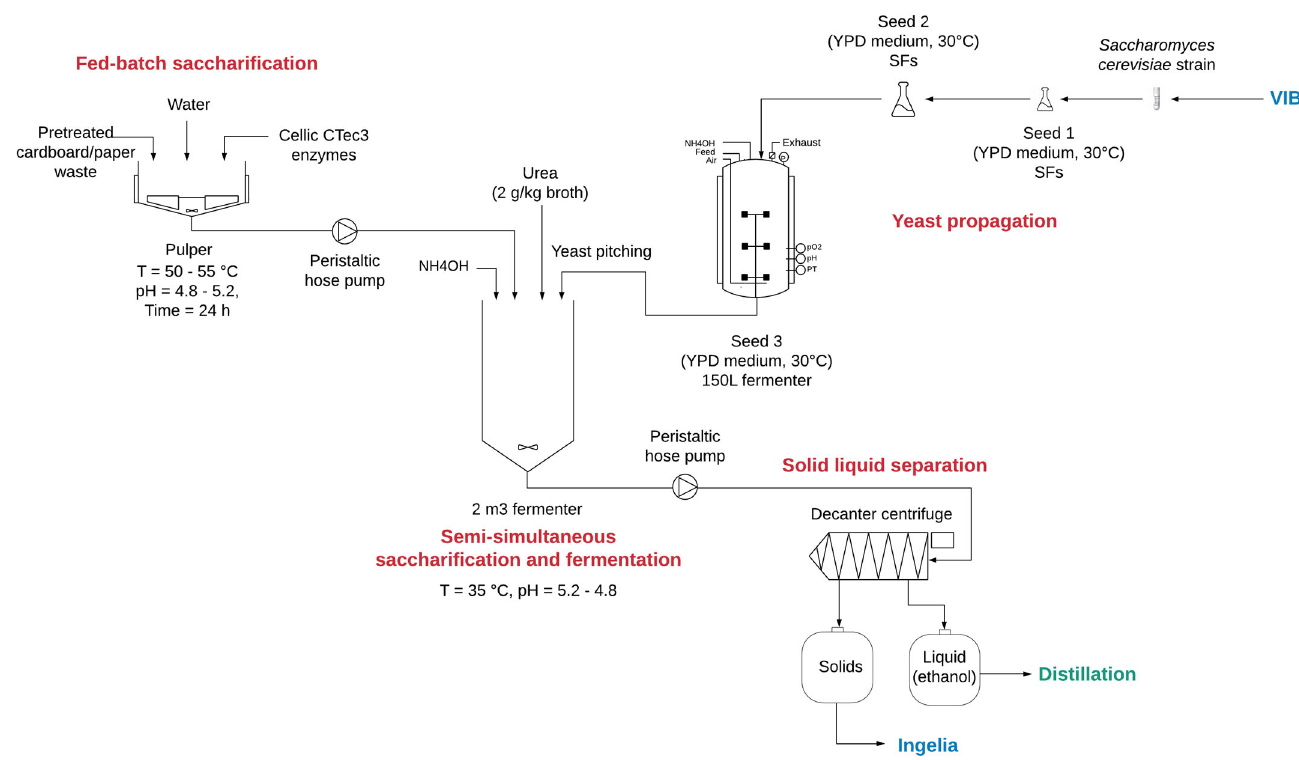
Figure 6. SSF set-up at 2 m 3 scale, demonstrated on pretreated cardboard and paper waste—process overview.